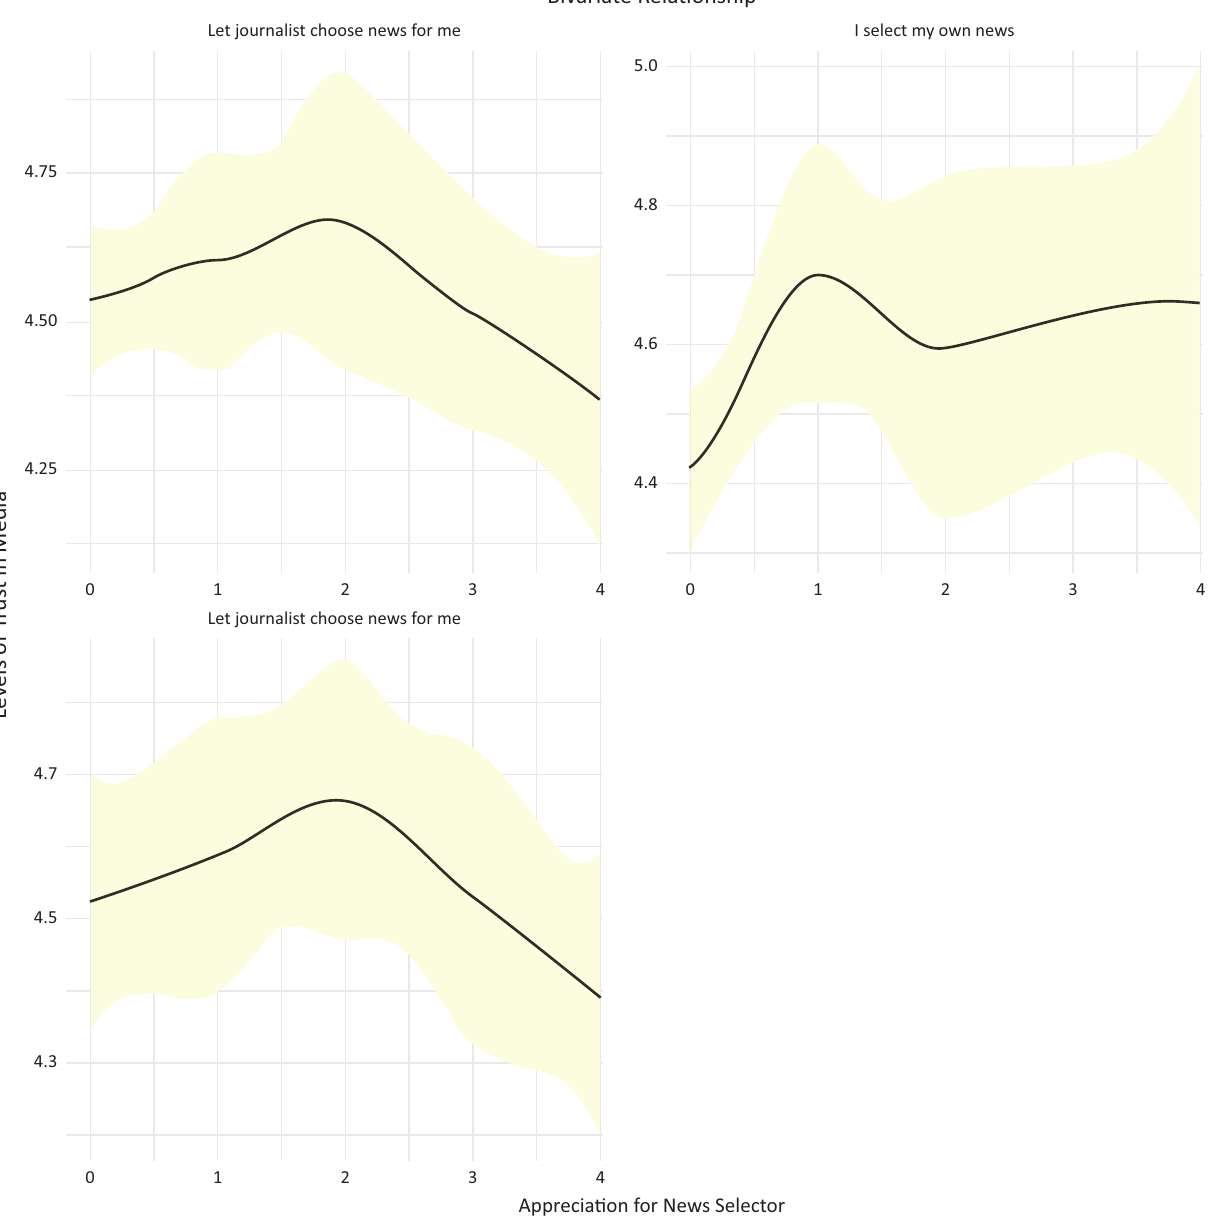
Figure 6. Bi‐variate relations between news selectors and trust in